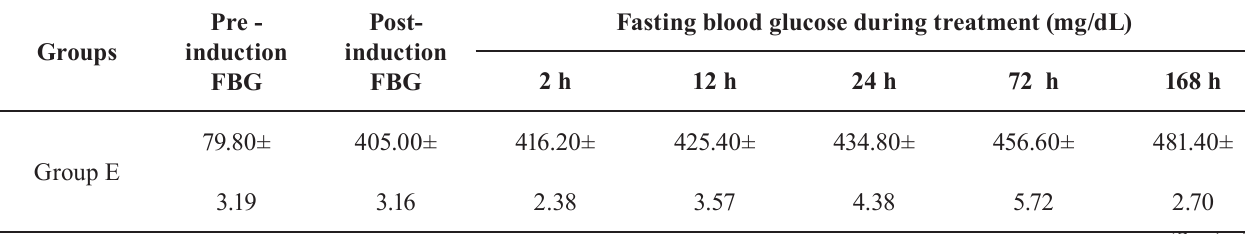
Table- II - Fa sting blood glucose levels (mg/dL)in mice (n=5) at different time intervals during treatment